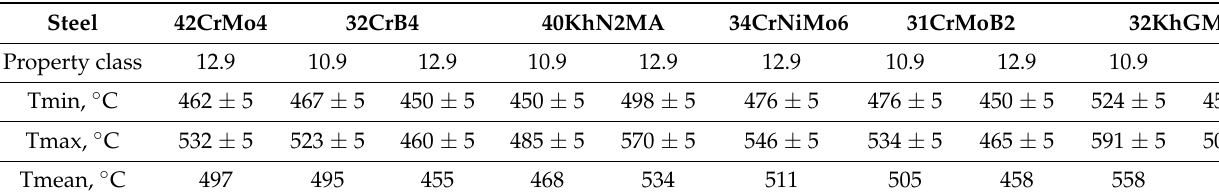
Table 6. Upper and lower limits of tempering temperatures at which mechanical properties corre- sponding to property classes 10.9 and 12.9 are achieved, as well as the arithmetic mean value of the found temperature range.